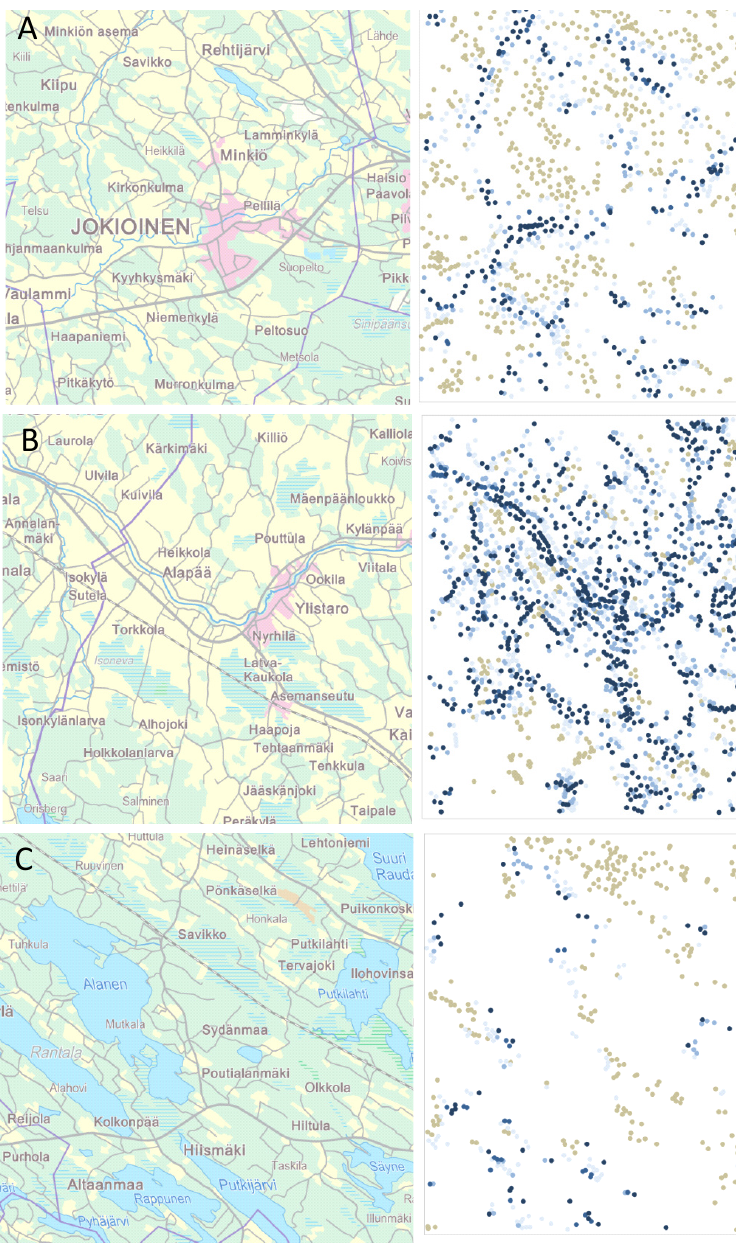
Fig. 9. Differences in frequency of fields and access to water resources depending on distance to closest waterway. On the right hand side figures, one dot indicates one field in a 10 × 10 km grid. The darkest blue indicates that the field has direct contact with a shoreline of a waterway, dark blue that it is at ≤50 m from shoreline, blue ≤100 m, light blue ≤300 m apart and beige >300 m apart. There are three example sites: Jokioinen (A) in Häme, Ylistaro (B) in Etelä-Pohjanmaa and Rantasalmi (C) in